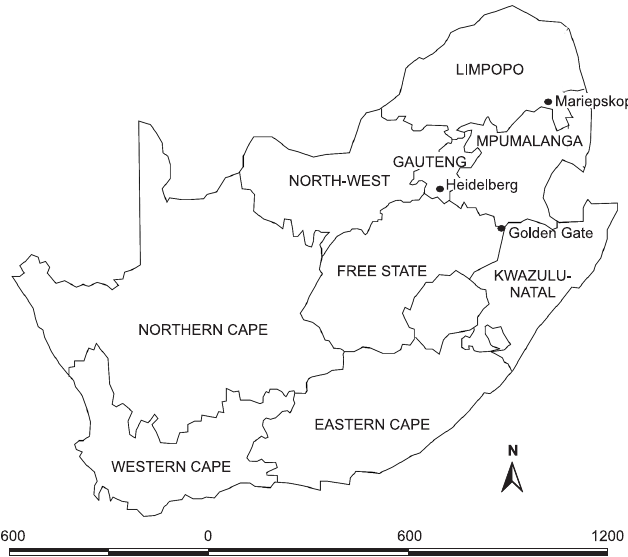
Fig. 2. Map of South Africa showing the nine provinces and three localities of